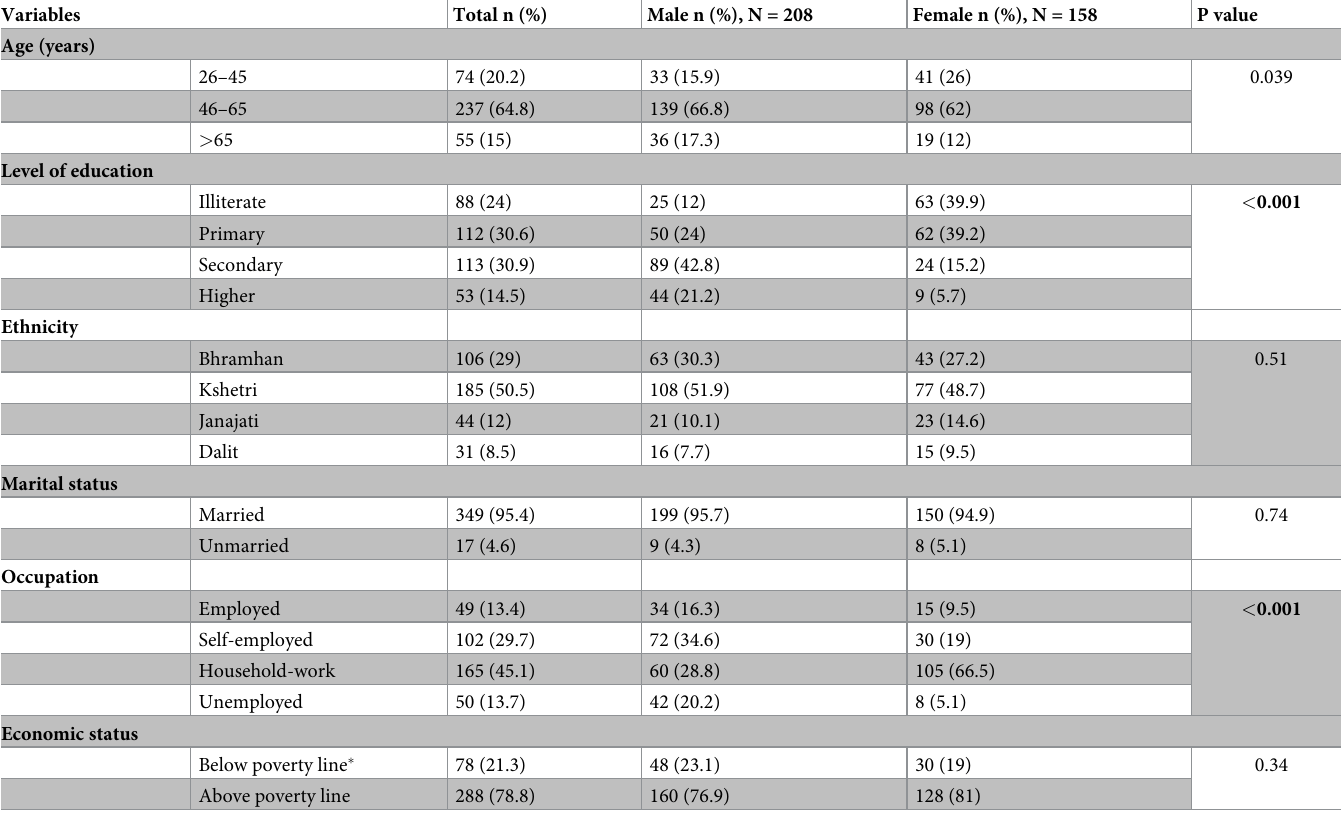
Table 1. Distribution of socio-demographic characteristics of study participants by gender (N =